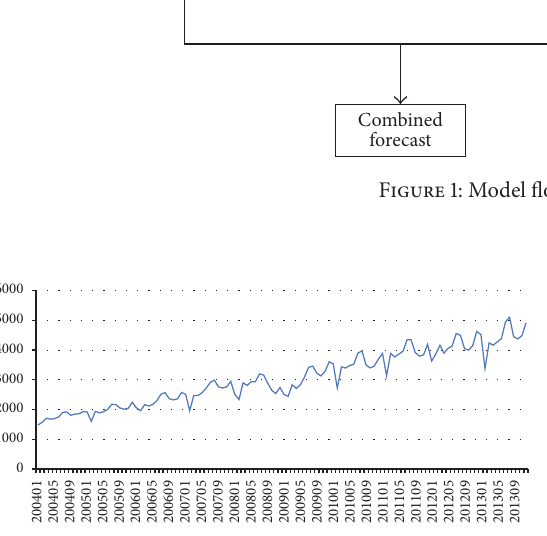
Figure 2: Monthly electricity consumption of China from January 2004 to December